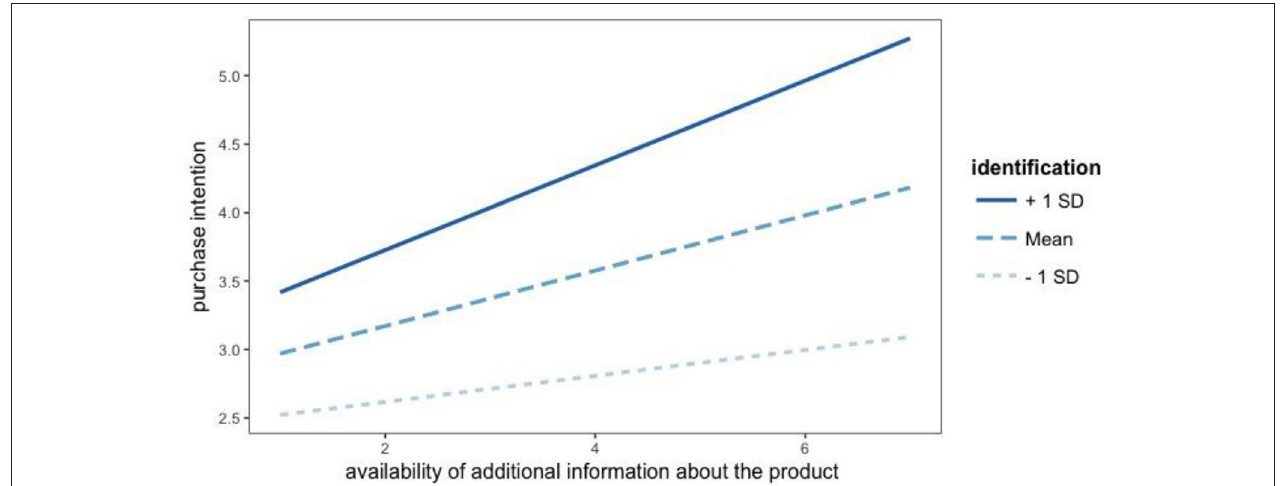
FIGURE 2 | Effect of additional information about the product and identification on purchase